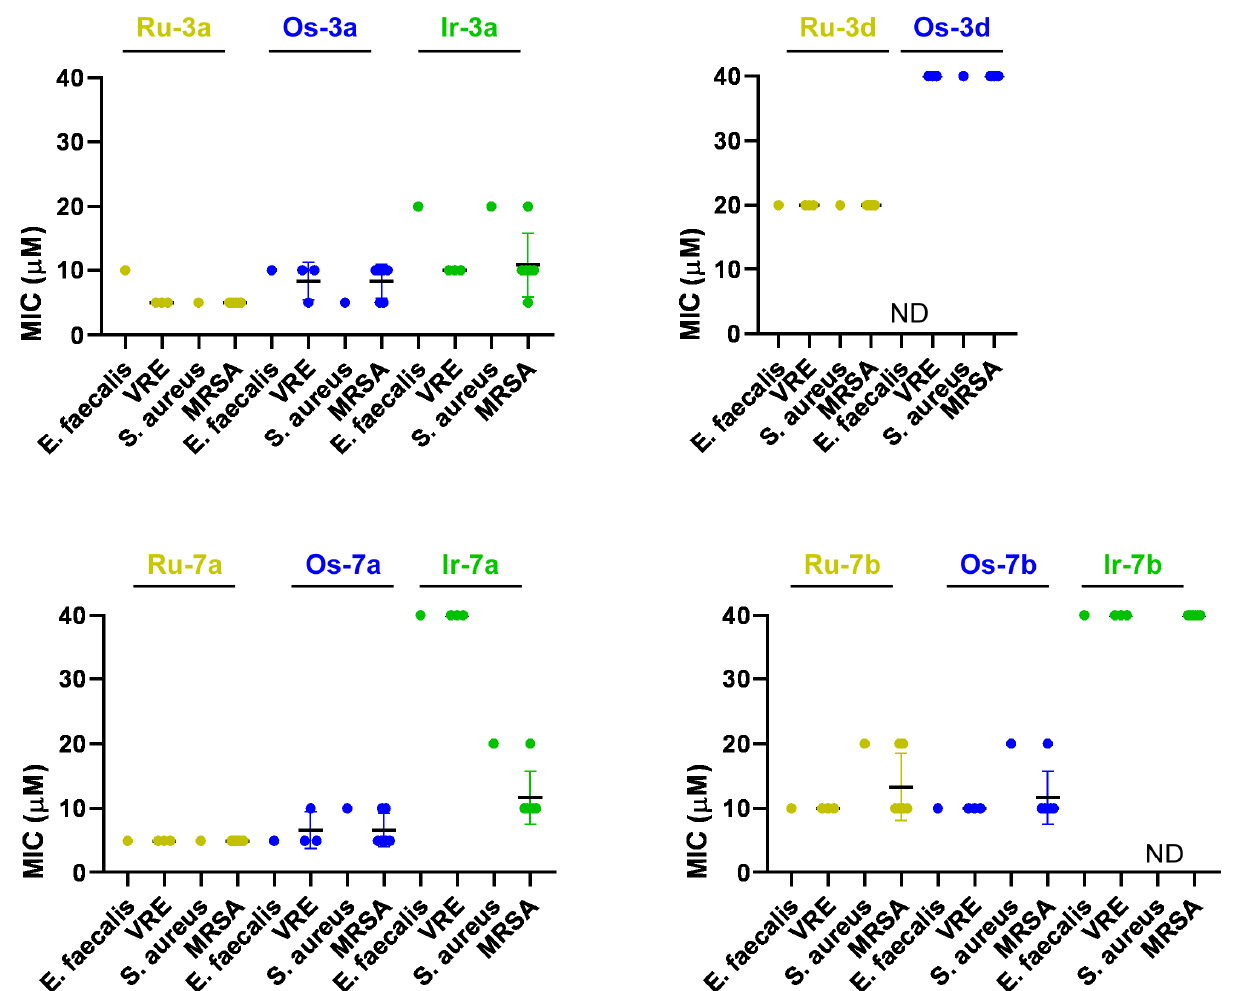
Figure 9. Complexes of the C -glucosaminyl heterocycles 3a , 3d , 7a and 7b exert bacteriostatic activity against reference strains and clinical VRE and MRSA isolates. The MIC values of the complexes were determined against the reference strains of S. aureus (ATCC29213) and E. faecalis (ATCC29212) and against clinical VRE and MRSA isolates by microdilution assays (repeated at least twice in duplicate), as described in Materials and Methods. Abbreviations: MRSA—methicillin-resistant Staphylococcus aureus , VRE—vancomycin-resistant Enterococcus , ND—not detected, MIC > 40 µ M, Veh—vehicle. Color code: khaki—ruthenium complex, blue—osmium complex, green—iridium complex.